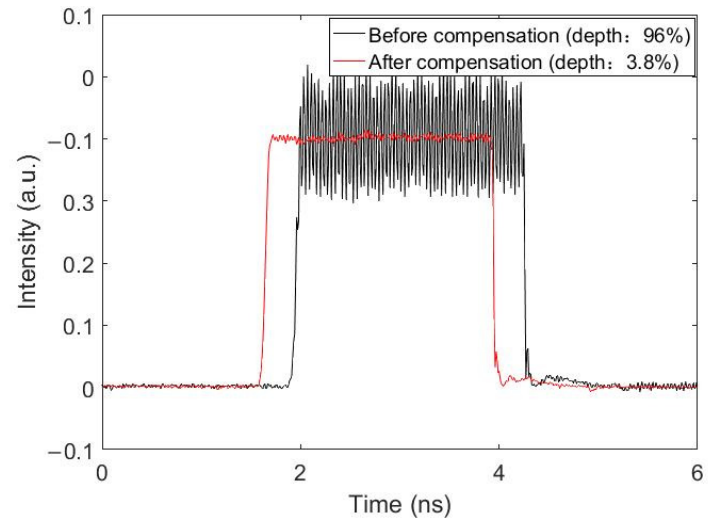
Figure 5. Time–domain pulse diagram before and after compensation.